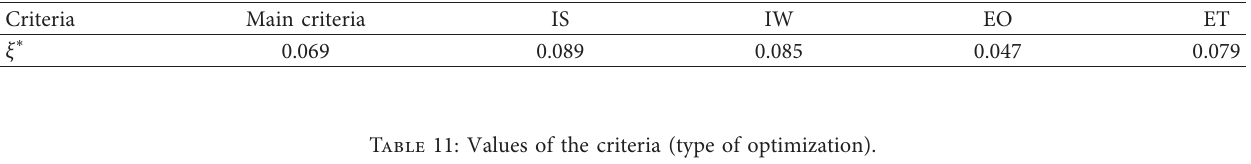
Table 10: Values of consistency for main criteria and subcriteria.